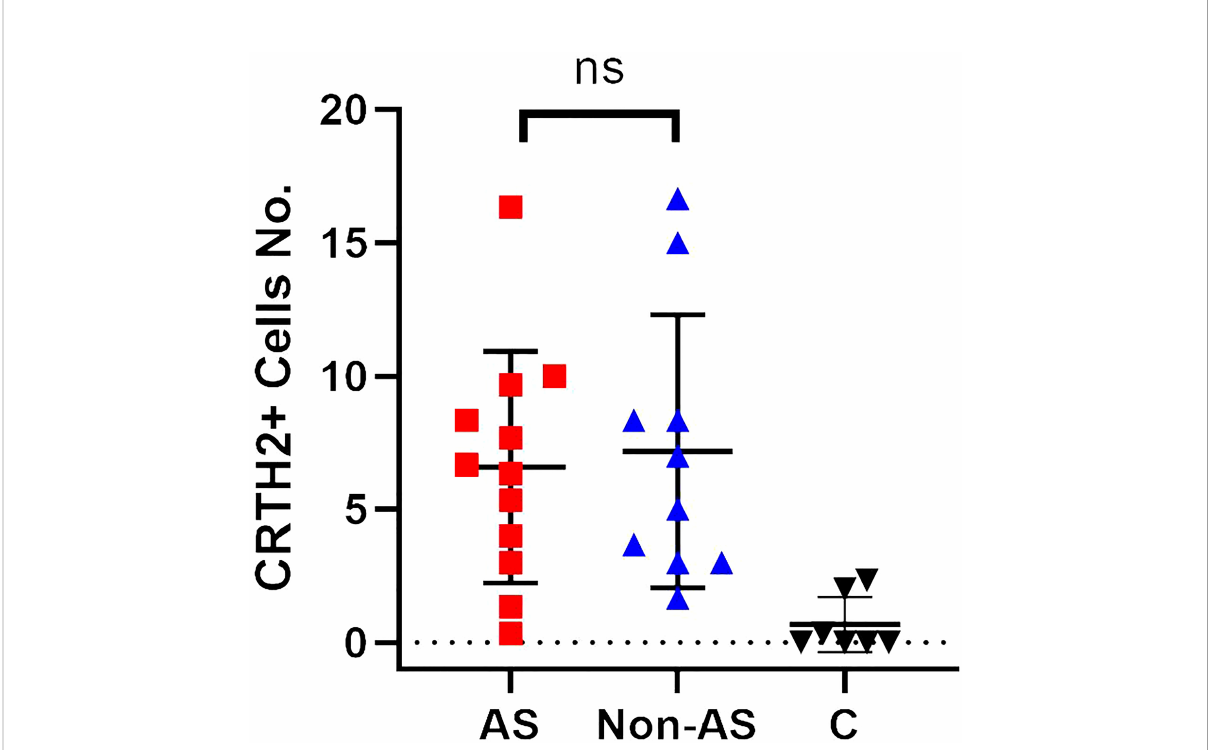
FIGURE 4 A dot plot showing positive CRTH2 cells/hpf for tissue samples from nasal polyps with concomitant asthma (AS) (n = 12) / nasal polyps without concomitant asthma (Non-AS) (n = 10) / control subjects (n = 7). ns, not signi fi